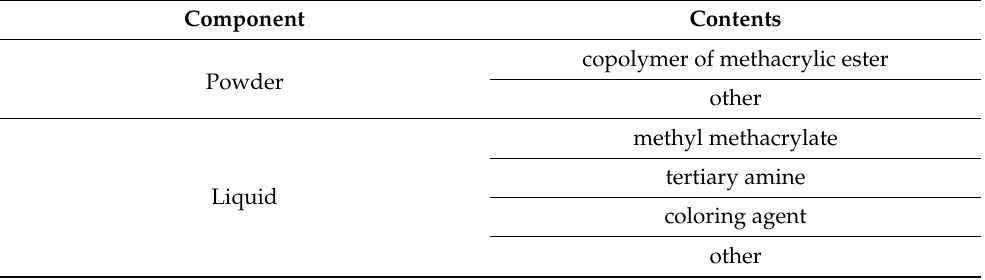
Figure 1. Structure of montmorillonite and nanoporous silica. Table 1. Components of Orthocrystal.